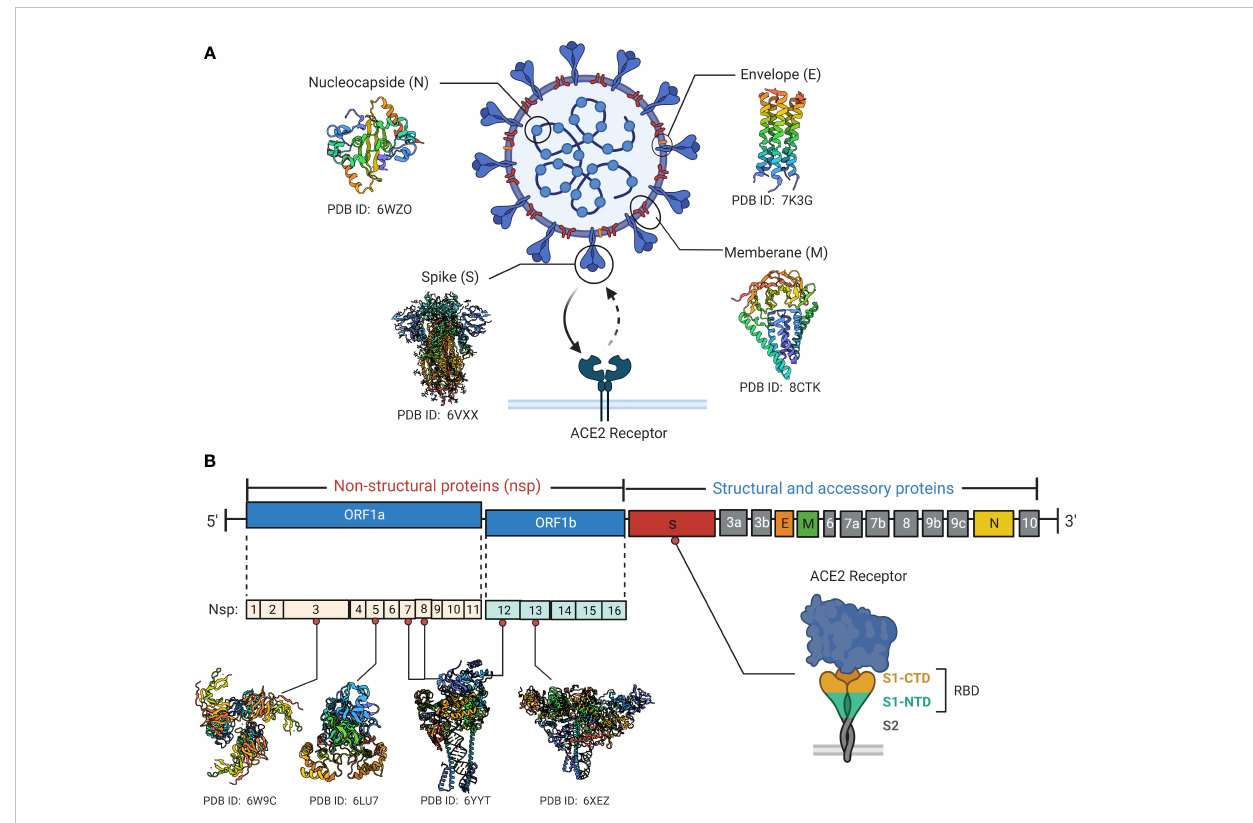
FIGURE 1 SARS-CoV-2 viral protein structure and genomic organization. (A) Schematic diagrams of the structural characteristics of SARS-CoV-2 as well as the crystal structures of key structural proteins obtained from RCSB protein data bank (PDB). The spike protein binds to the cell surface ACE2 receptor through the RBD. (B) Diagrammatic representation of SARS-CoV-2 genome contains 12 open reading frames (ORF) and encodes 16 non-structural proteins (nsp1-16), 9 accessory proteins (ORF3a-10) and 4 structural proteins. Crystal structures of Some key non-structural proteins are presented as well. Created by